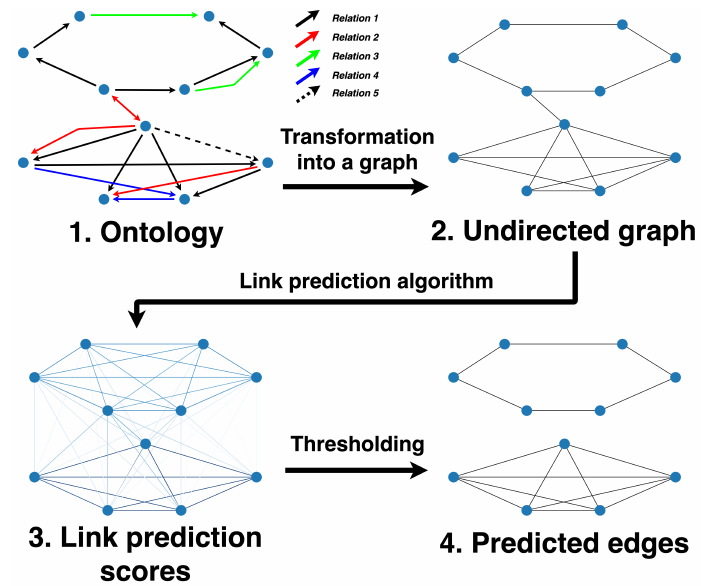
Figure 1. Overview of the link prediction